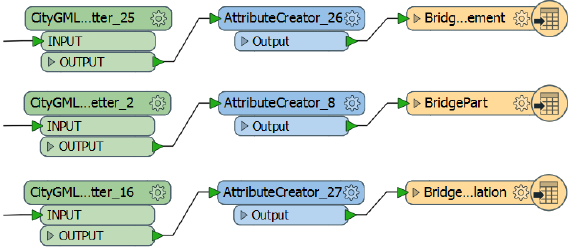
Figure 4: Conversion of the Bridge